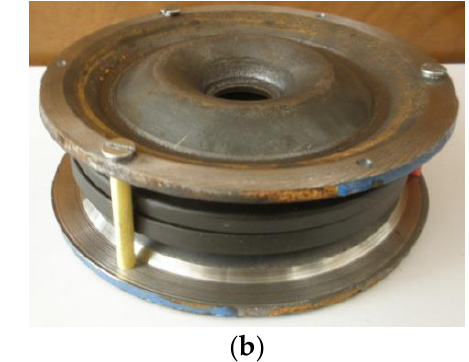
Table 4. Technical parameters of disc springs and bearing plates of a mechanical force